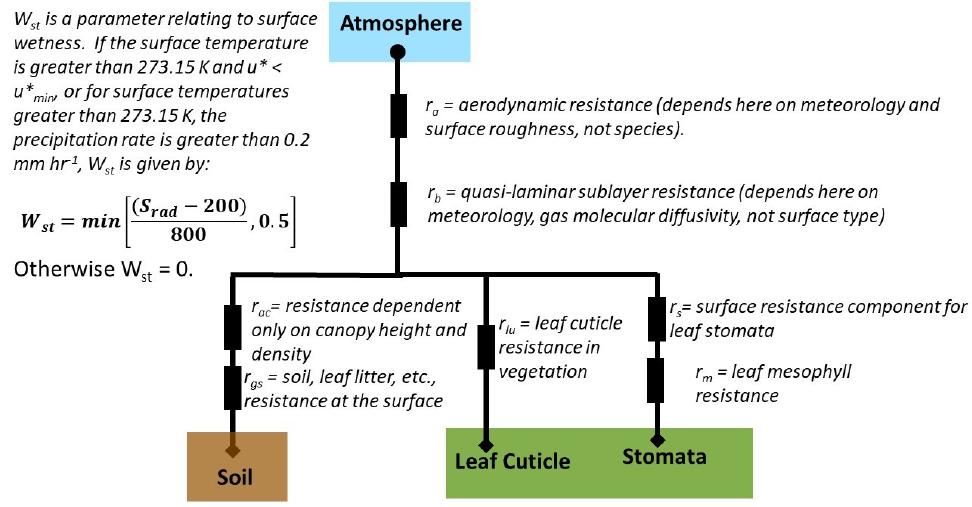
Figure B5. Resistance diagram for the ECCC GEM-MACH model (Zhang scheme).